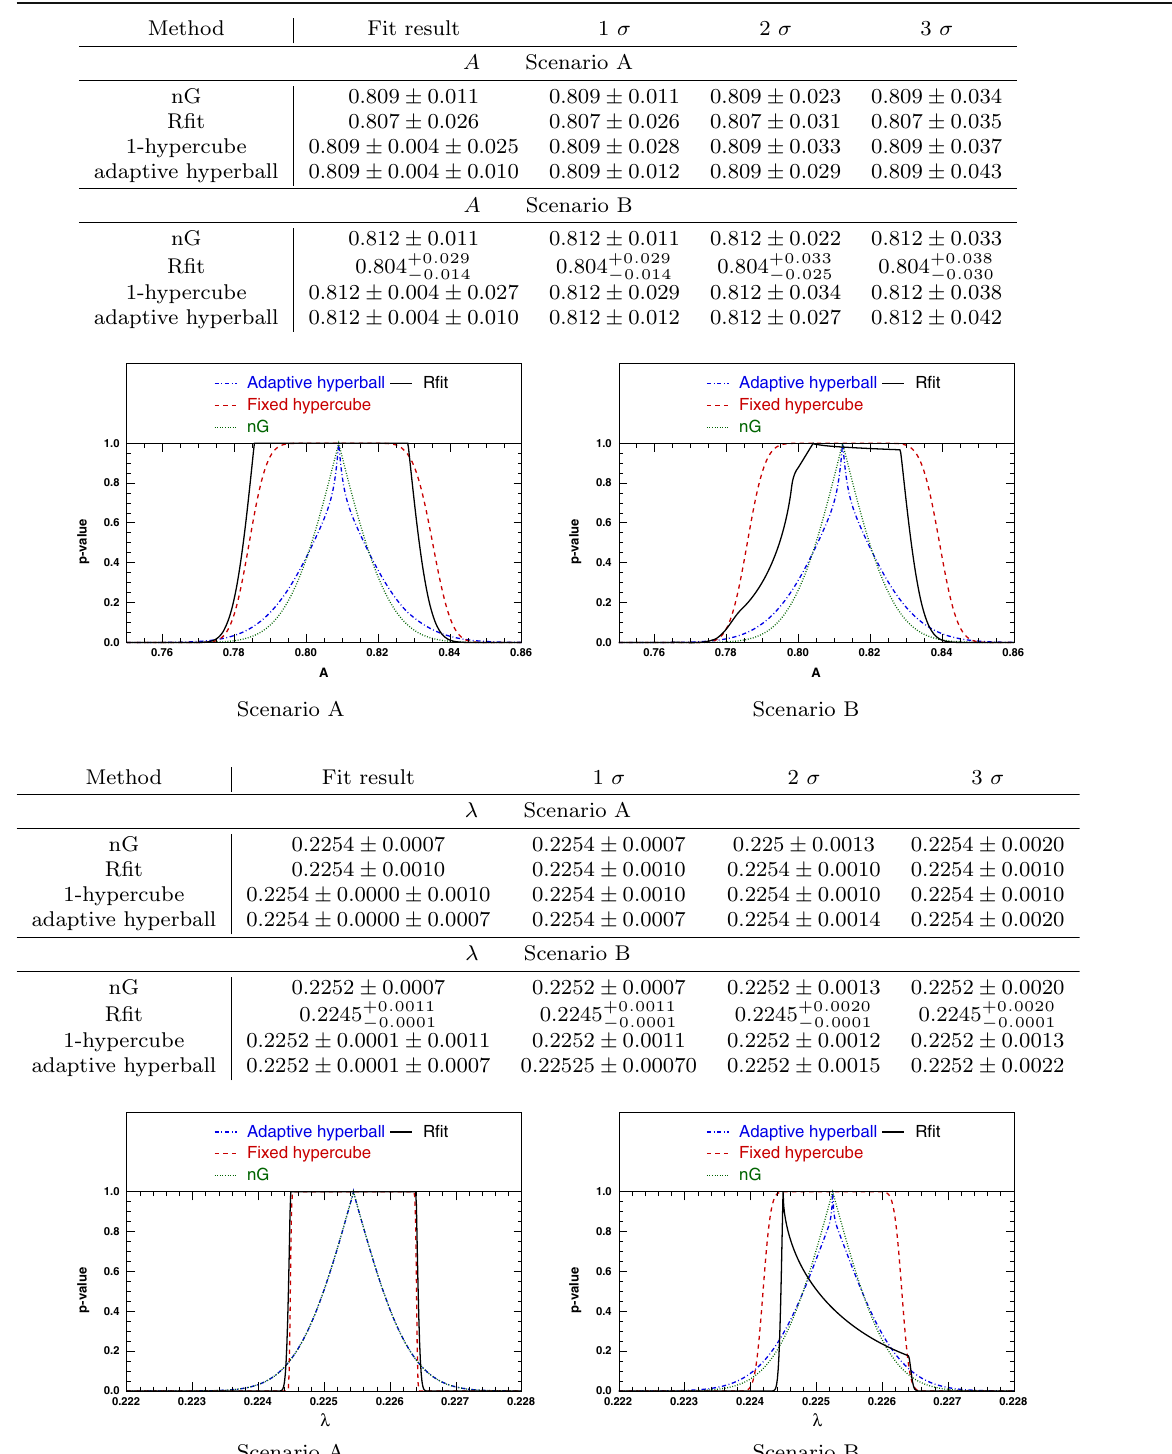
Table 13 Numerical results and p values for the CKM parameters in A and λ for Scenarios A and B, depending on the method chosen. For each quantity, we provide the error budget, whenever possible, and the plots of the p values for Scenarios A (left) and B